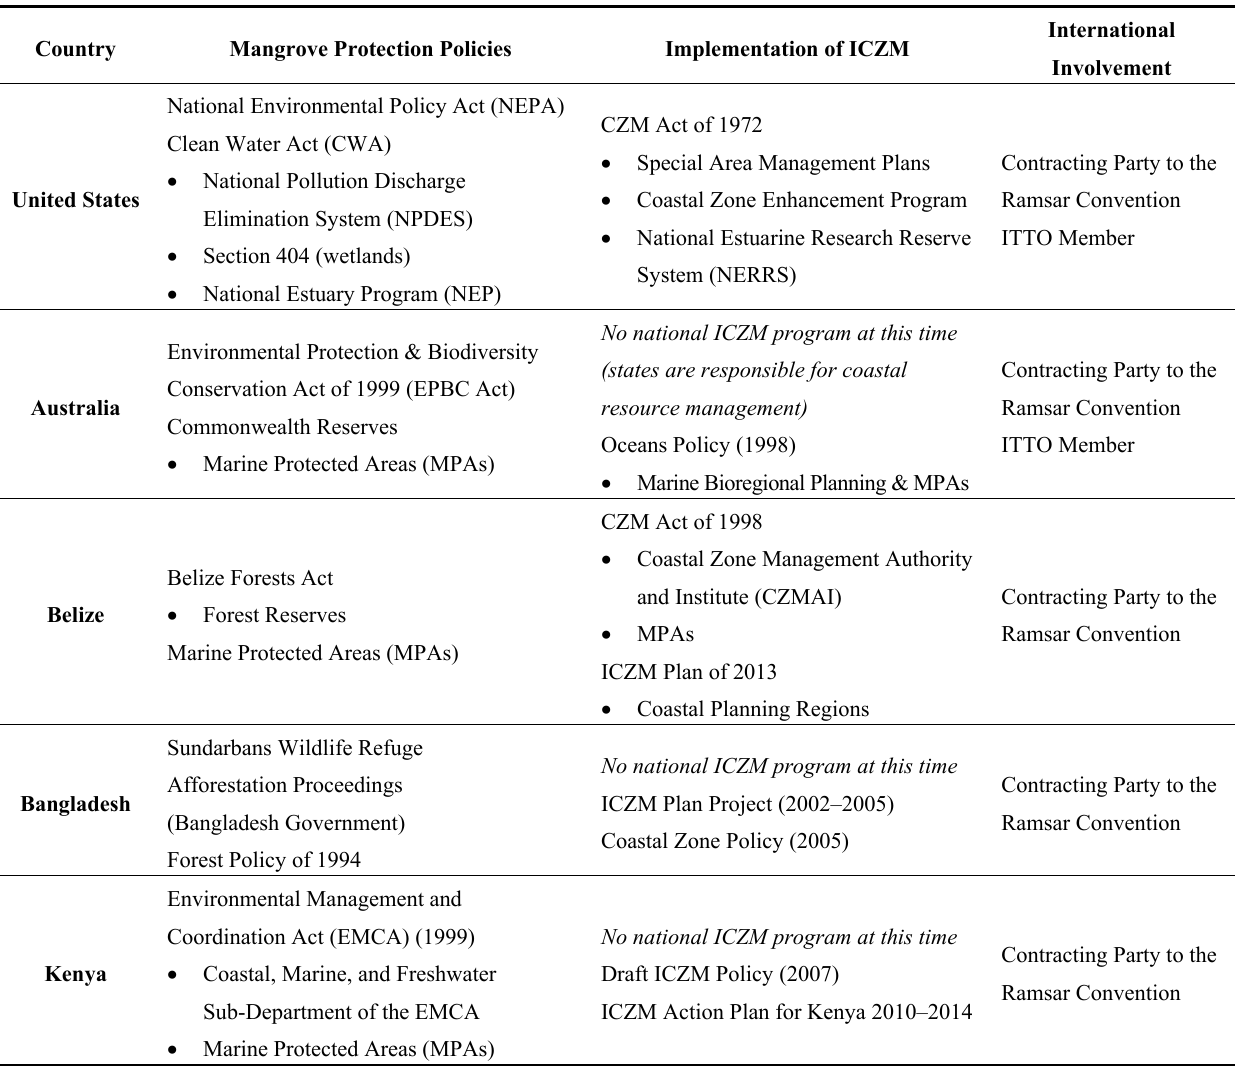
Table 4. Overview of the five case study countries and their management programs related to mangrove